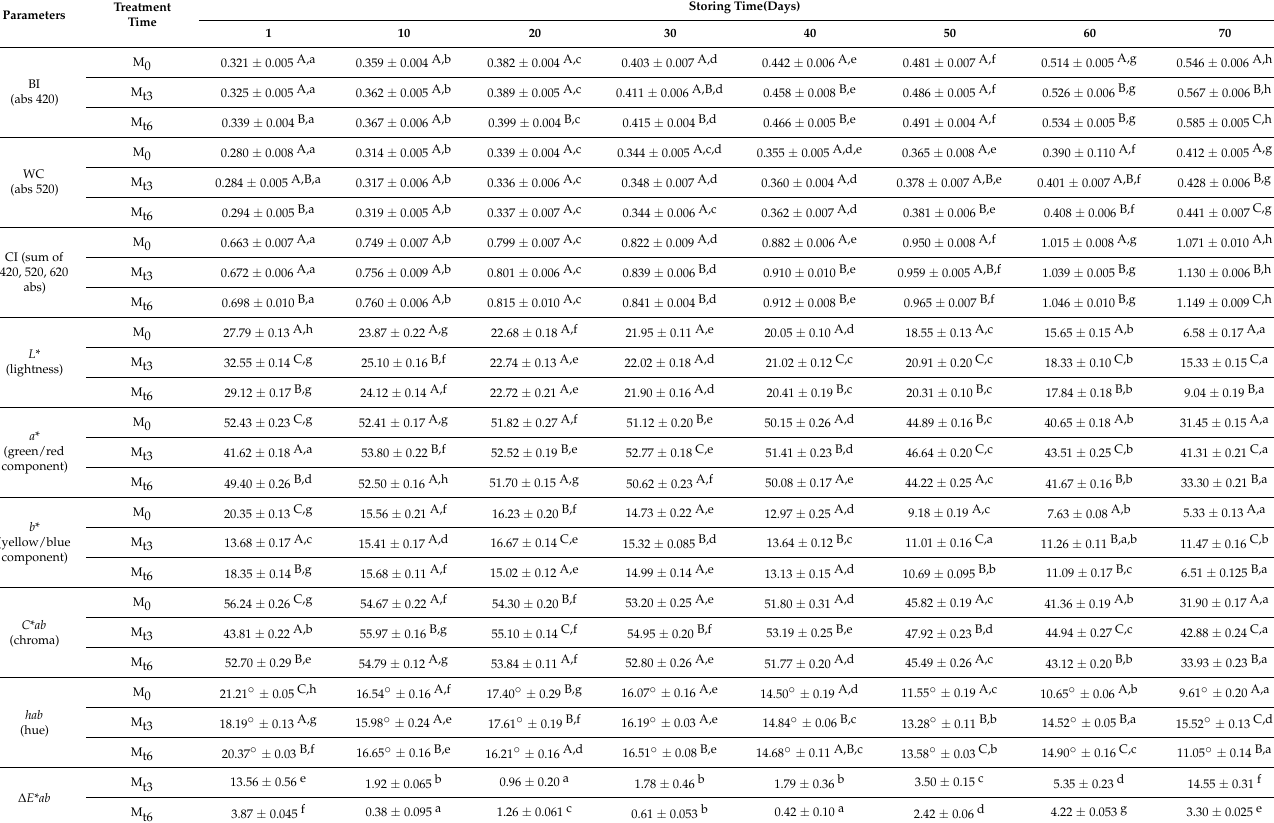
Table 1. Effect of microwave treatment time and storage time on colour characteristics of red wine.